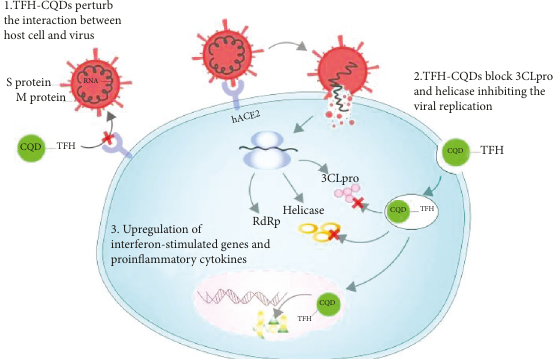
Figure 2: A schematic representation of the role of triazole functionalized heteroatom codoped carbon quantum dots against human